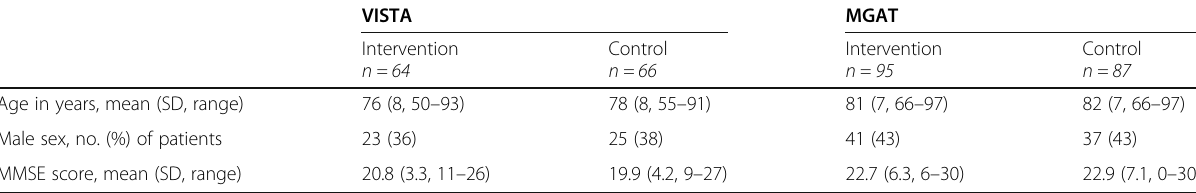
Table 2 Sample characteristics at baseline